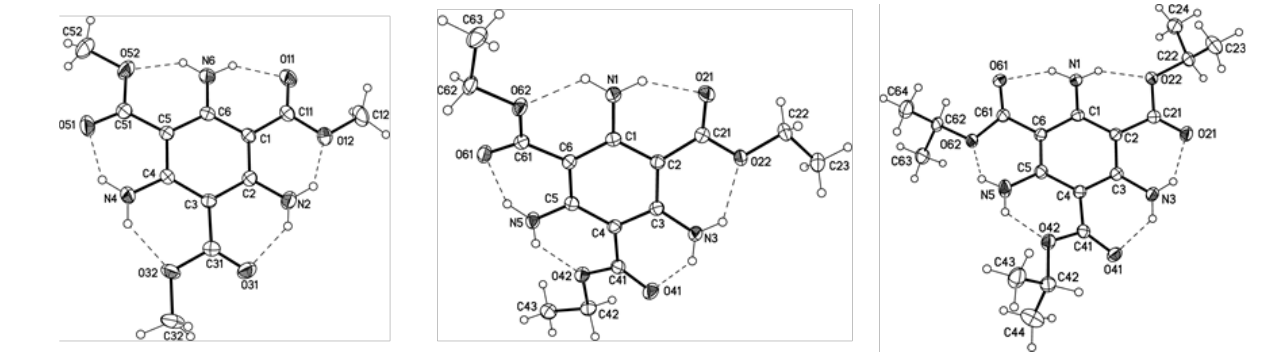
Figure 2. Molecular structures of 2a , 2b and 2c , intramolecular hydrogen bonds drawn at dashed lines, displacement parameters are drawn at 50% probability level (for details, see supporting information and cif-file).